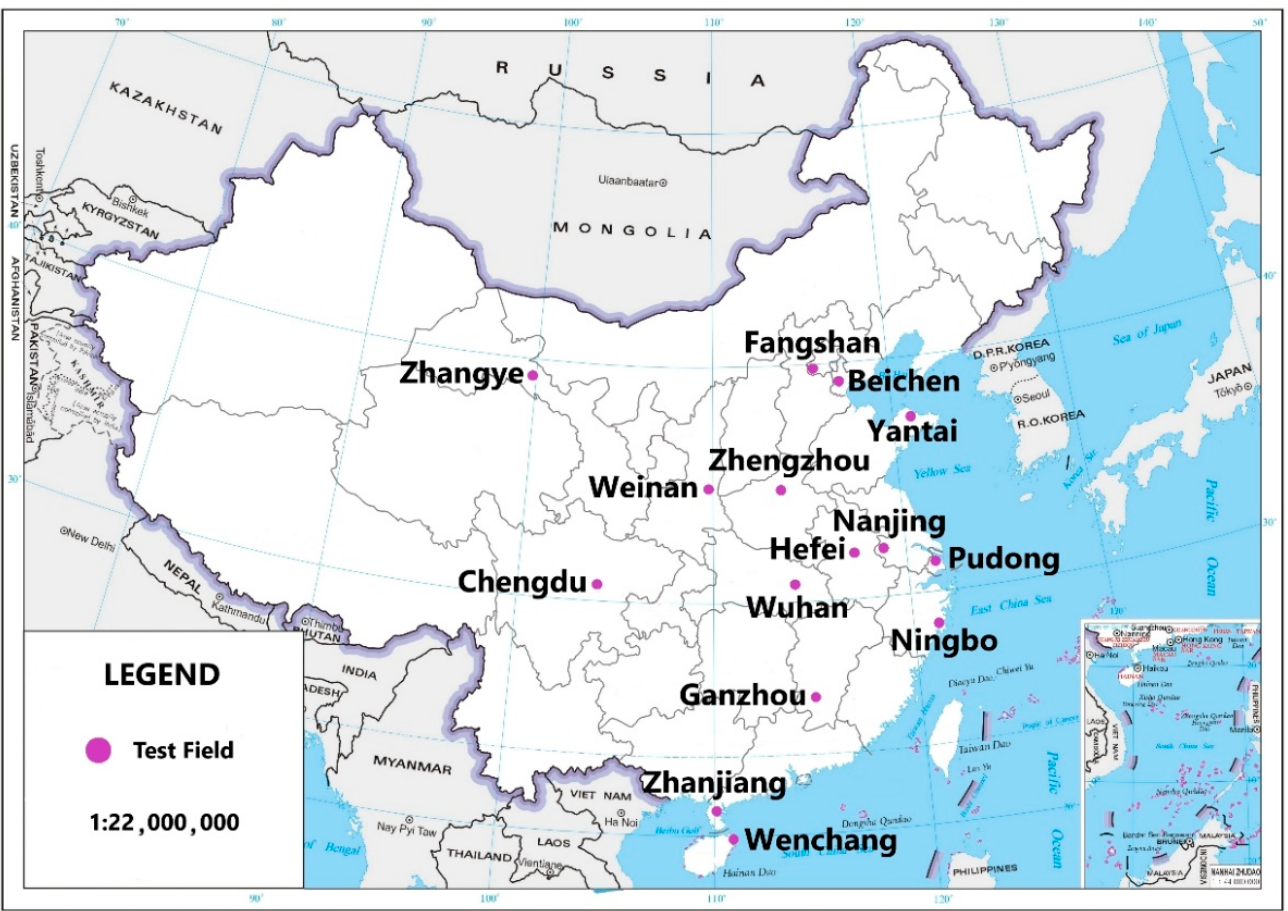
Figure 2. Distribution of the sixteen test fields.